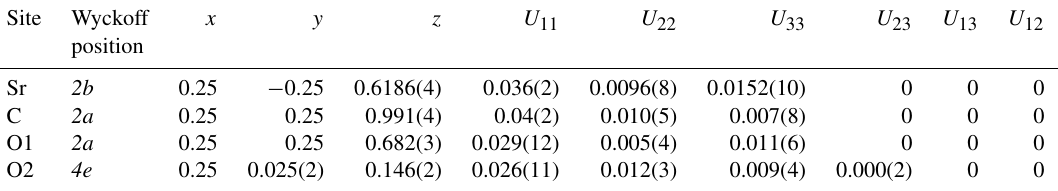
Table 5. Atomic coordinates and anisotropic displacement parameters U ij [Å 2 ] for post-aragonite SrCO 3 -II at 26.3GPa (space group Pmmn ).